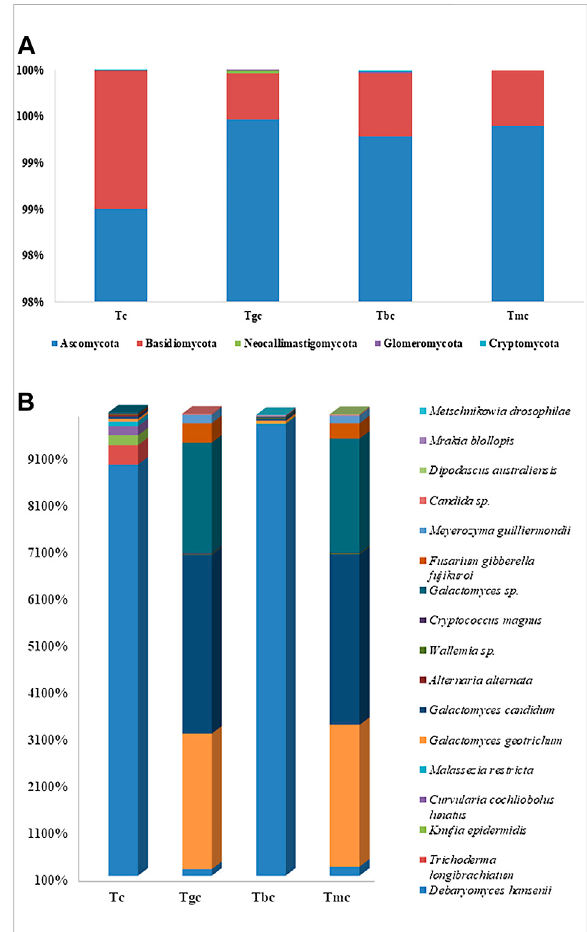
FIGURE 2 (A) Relative abundance (%) gut fungal diversity at the phylum level after probiotic feeding. (B) Relative abundance (%) of gut fungal diversity at the species level after probiotic feeding, and species with a percentage less than 0.1% were